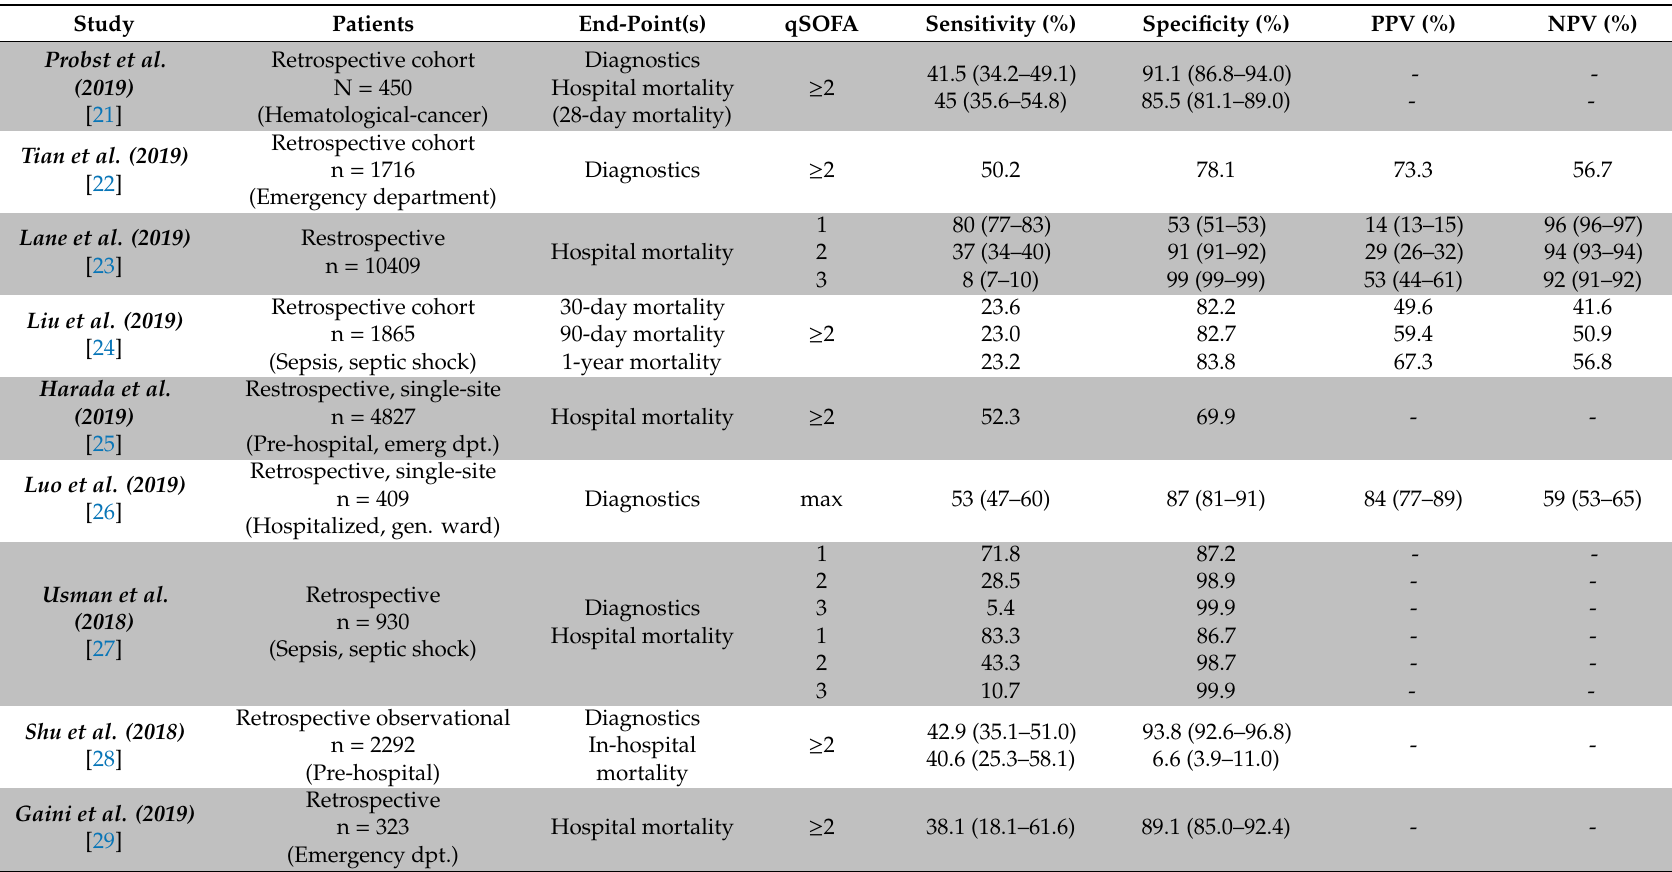
Table 1. Recent studies validating the sensitivity, specificity, and prognostic values of qSOFA scores. PPV: Positive predictive value; NPV: Negative predictive value; ED: Emergency